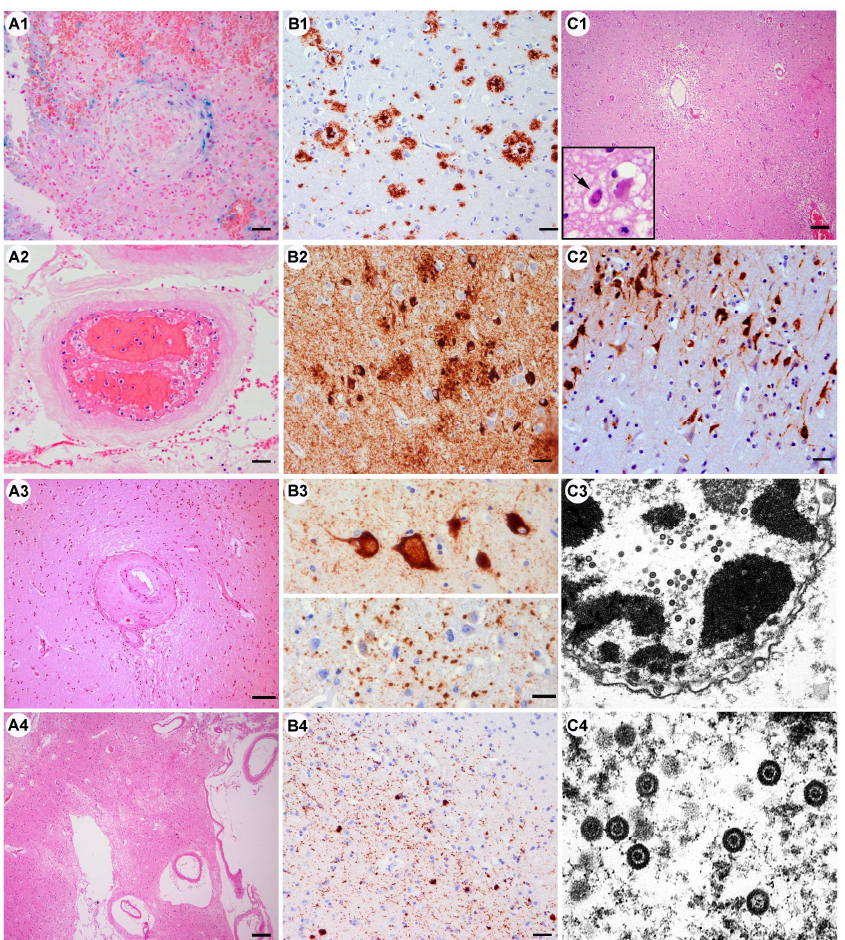
Figure 3. Other conditions. ( A1 – A4 ) Alteration of the vessel wall and vascular lumen. ( A1 ) Vascular occlusion surrounded by fresh and old blood remnants (Pearl’s blue) and reactive tissue changes with gliosis, microglia, and macrophages (case 26). ( A2 ) Early and partial fibrin clot in a meningeal vessel with entrapped leukocytes and erythrocytes. ( A3 ) Eccentric thickening and fibrosis of small sized arterioles and perivascular tissue rarefaction (case 25) characteristic of small vessel disease that occurs in patients with chronic vascular risk factors. ( A4 ) Prominent perivascular tissue rarefaction status cribosus of the basal ganglia (case 1) (all HE-stained sections). Scale bars: ( A1 , A2 ) 20 µ m; ( A3 ) 50 µ m; ( A4 ) 100 µ m. ( B1 – B4 ) Pre-existing neurodegenerative pathology. ( B1 ) Alzheimer’s disease neuropathological change. ßA4-amyloid deposits in brain parenchyma in form of compact and diffuse plaques (case 1) and within the wall of leptomeningeal and cortical vessels (inset, amyloid angiopathy; case 3). ( B2 ) Tau-positive neurofibrillary pathology with abundant fine neuropil threads, intraneuronal neurofibrillary tangles, and dystrophic neurites surrounding amyloid plaques (case 1). ( B3 ) Tau positive argyrophilic grain pathology with several enlarged “ballooned” neurons in the amygdala (upper panel) and grain-like structures in the neuropil (lower panel; case 25). ( B4 ) Alpha-synuclein immunoreactive Lewy bodies and Lewy neurites in the olfactory bulb (case 4). Scale bars: ( B1 , B2 , B4 ) 20 µ m; ( B3 ) 10 µ m. ( C1 – C4 ) Concomitant HSV-1 infection. (C1) Diffuse hypoxic cortical damage with tissue pallor, endothelial activation, and diffuse inflammatory infiltrates. Inset: intranuclear neuronal inclusion. ( C2 ) Immunohistochemistry shows abundant HSV1 viral antigens in cortical neurons. ( C3 , C4 ) Ultrastructural identification of neuronal intranuclear viral particles with typical morphology of Herpes simplex. (case #32). Scale bars: ( C1 ) 100 µ m ( C2 ) 20 µ m; ( C3 ) original magnification × 30,000, ( C4 ) ×